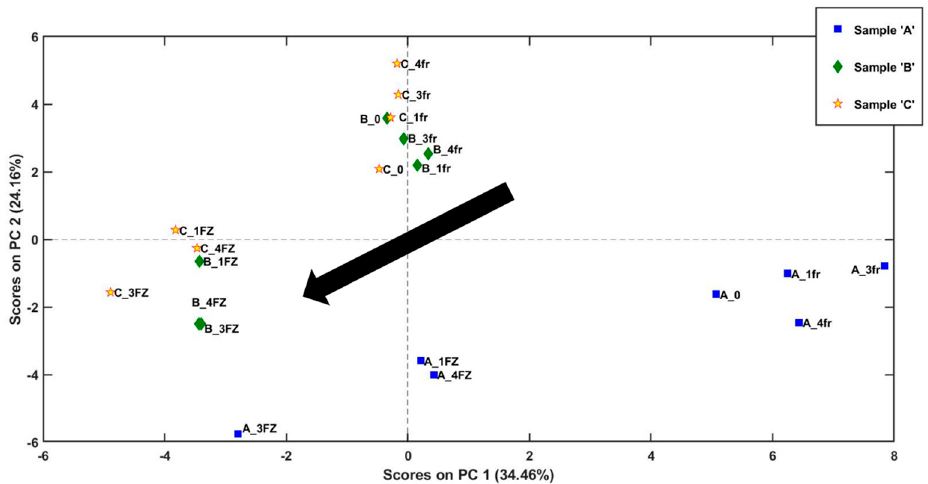
Figure 4. Analysis of VOCs of bread samples sampled with Arrow-SPME. PC1 vs. PC2 scores plot obtained by PCA applied on selected areas from PARADISe analysis. The samples labelled ‘fr’ were stored in fridge, the samples labelled ‘FR’ were stored in freezer. The number on the labels indicates the number of weeks of storage.